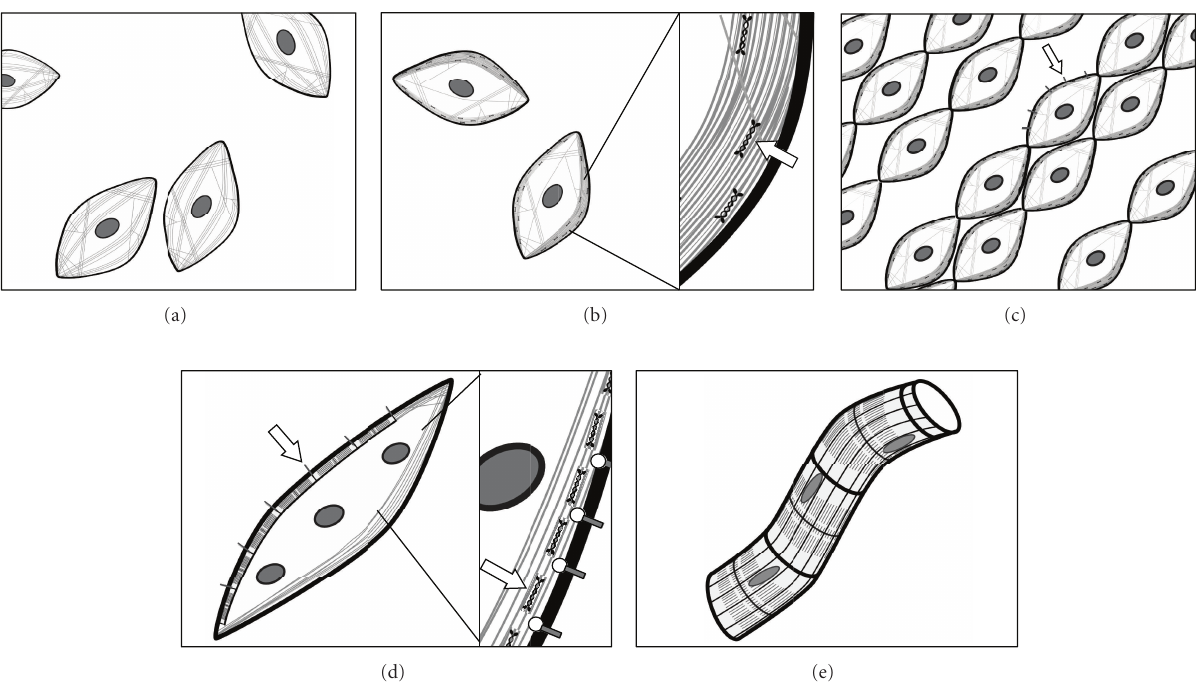
Figure 1: Summary of steps involved in myocyte di ff erentiation and myofibrillogenesis, with regards to actin dynamics. (a) Proliferating myoblasts are derived from determined myotome cells and possess an unspecialized actin cytoskeleton (grey lines). (b) As di ff erentiation begins, these cells aggregate, characterized by the formation of localized stress fibers in a cortical actin wall (insert). Contractile function of these fibers is provided by nonmuscle myosin (NMM, arrow). (c) Myoblasts align themselves concurrent to substrate attachment and the elaboration of protocostameres (arrow). The stress-fiber-like cortical actin and NMM will form the premyofibril templates for subsequent myofibril assembly. (d) Fusion occurs, resulting in the formation of multinucleated myotubes. Myofibrils begin to form at the cell periphery, centered on costamere attachment points (arrow), constructed from premyofibril templates (insert). Premyofibrils consist of alternating bands of membrane-associated α -actinin (circles) and NMM (arrow). (e) As the myocyte matures, additional myofibrils will fill all available space, interconnected with one another and with organelles by desmin intermediate filaments. New myoblasts will continue to fuse to the terminal ends of the myotube to create a growing myofiber. Artwork by A.